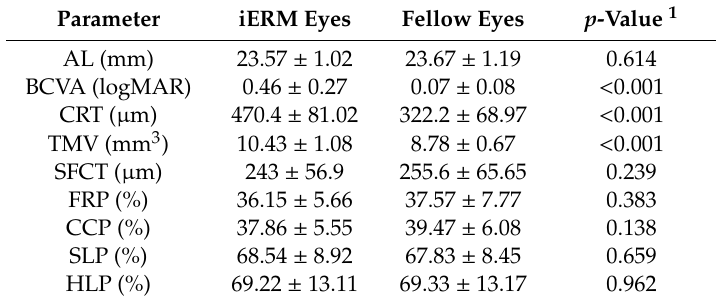
Table 2. Anatomical and functional parameters of iERM and fellow eyes at baseline